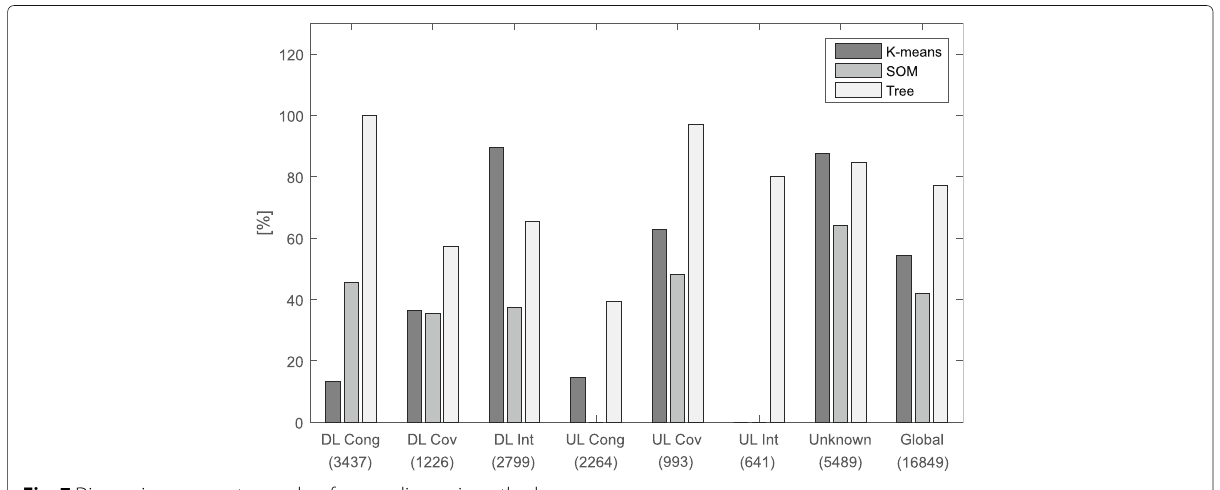
Fig. 7 Diagnosis success rate per class for user diagnosis methods